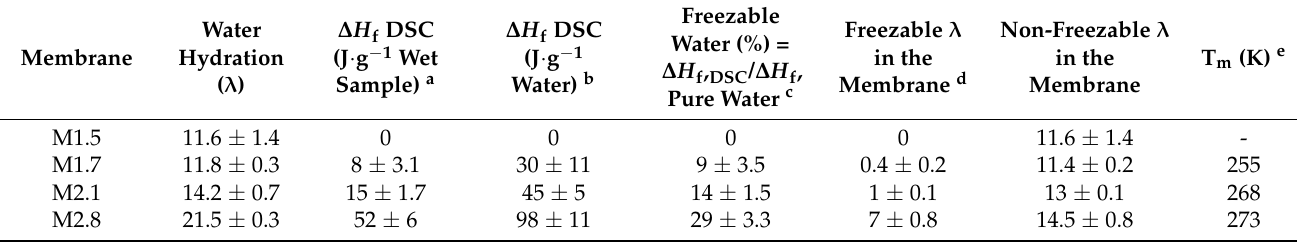
Table 3. Amount of freezable and non-freezable water in the membranes, their enthalpy and melting temperature.